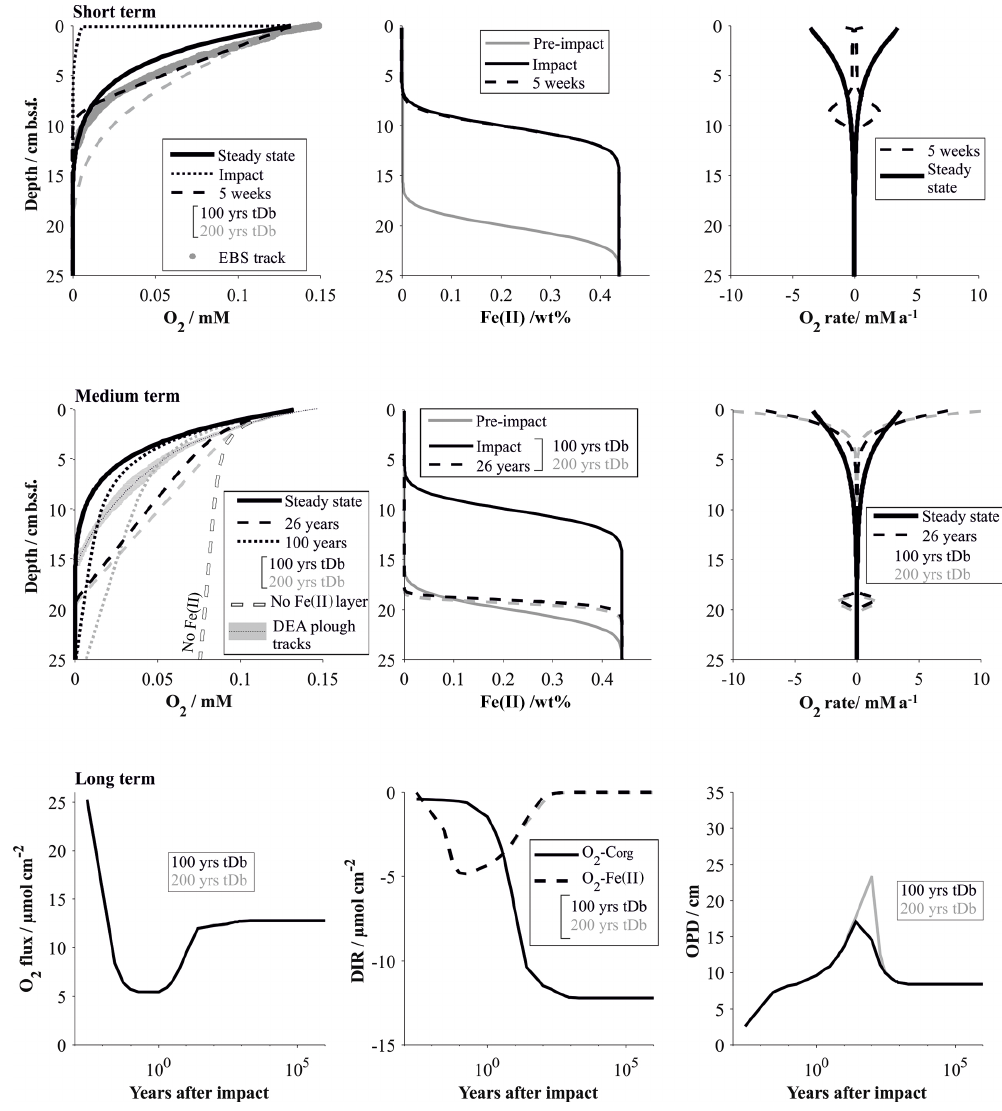
Figure 10. Impact simulations after a disturbance that causes the reactive upper 10cm to be removed. The short-term (up to 5 weeks, comparable to the EBS tracks) and medium-term (26 years, comparable to the DEA tracks) impacts are visualized by the respective O 2 profiles and the fluxes shaping the O 2 profiles. It is assumed that the oxygen penetration depth is impeded by a reactive Fe(II) layer. Note that the Fe(II) is assumed to be located at 20cmb.s.f. but is placed at 10cm if the upper 10cm is removed. For comparison the O 2 profile in the absence of a Fe(II) layer is also shown. The long-term impact is demonstrated by the surface flux of oxygen into the sediment, the depth-integrated reaction rates (DIRs) of oxygen with organic matter ( C org ) and with the reactive Fe(II) layer, and the oxygen penetration depth (OPD) over time. The influence of the bioturbation recovery time is shown by plotting the lines that correspond to a recovery interval of 100 and 200 years in black and grey,